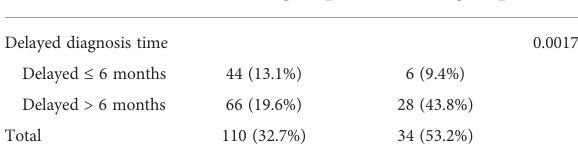
TABLE 3 Differences in the delayed diagnosis time between the two